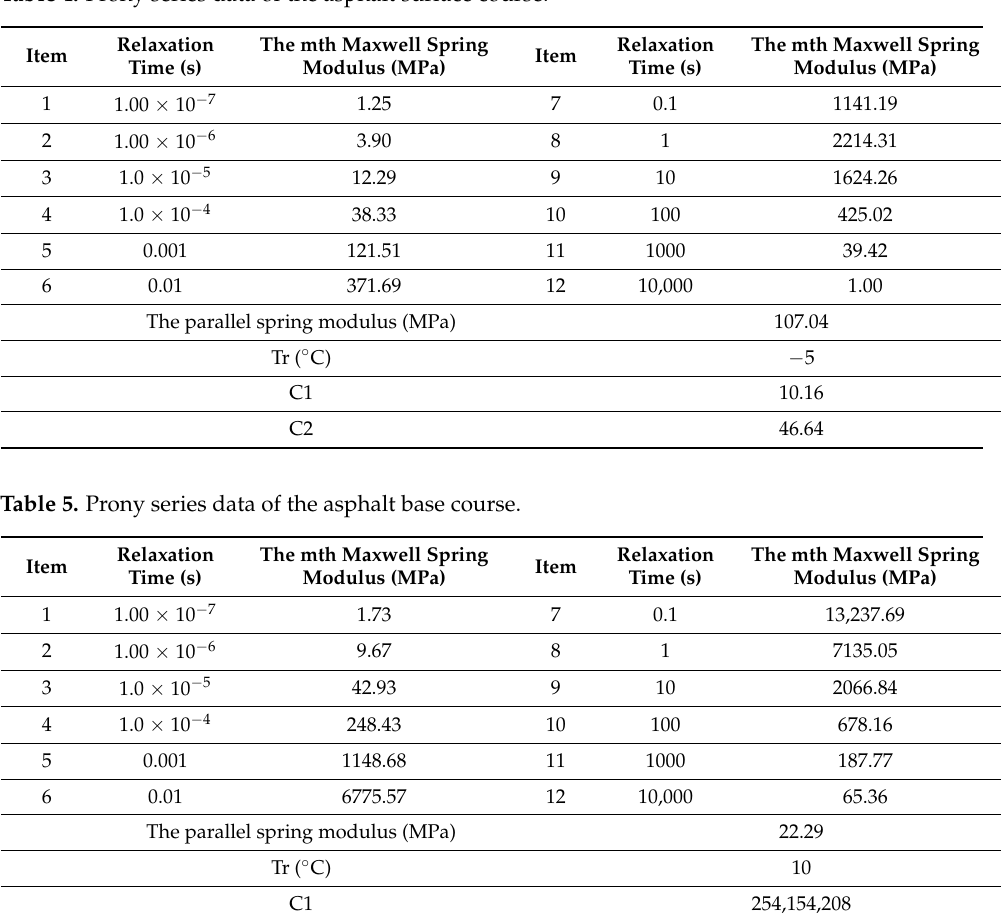
Table 4. Prony series data of the asphalt surface course.